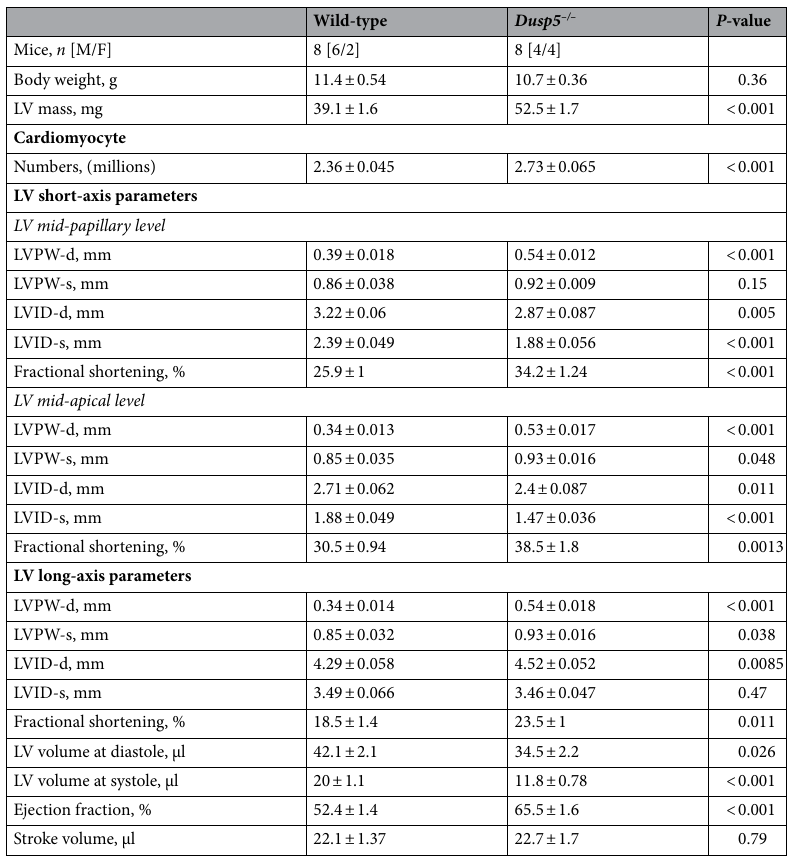
Table 1. Cardiomyocyte numbers, body weights, LV mass and dimensions and LV contractile function of 21-day-old C57BL/6 wild-type and Dusp5 –/– Mice. *C57BL/6 and Dusp5 –/– mouse litters were adjusted at P2 to 4 pups/dam). Transthoracic echocardiography, M- and B-modes, were performed in 21-day-old mice under light isoflurane anesthesia. Immediately following this procedure, cardiomyocyte numbers were determined in whole-ventricle cell-suspensions of disaggregated hearts using a hemocytometer. Cardiomyocytes were identified by their shape and size. Data were analyzed by unpaired 2-tailed Students t -test. Values are mean ± SEM. LV left ventricle, LVPWD-d LV posterior wall dimension at end-diastole, LVPWD-s LV posterior wall dimension at end-systole, LVID-d LV internal dimension at end-diastole, LVID-s LV internal dimension at